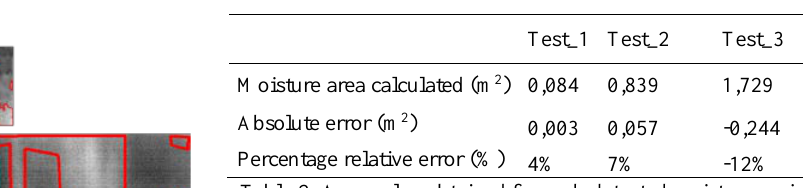
Table 2. Area value obtained for each detected moisture region